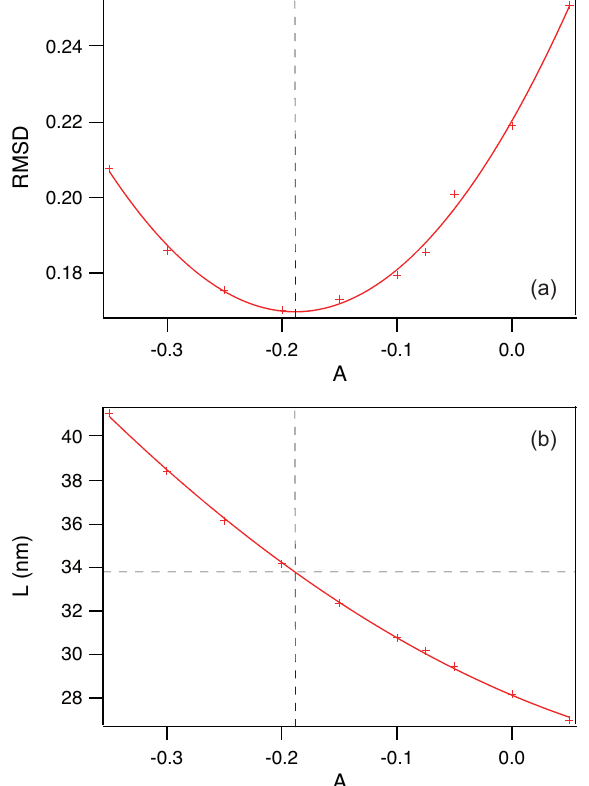
Figure 12. ( a ) Root-mean-square deviation (RMSD) between the experimental curve measured at T = 40 ◦ C and the theoretical curve as a function of A . ( b ) Value of L that minimizes the RMSD as a function of A